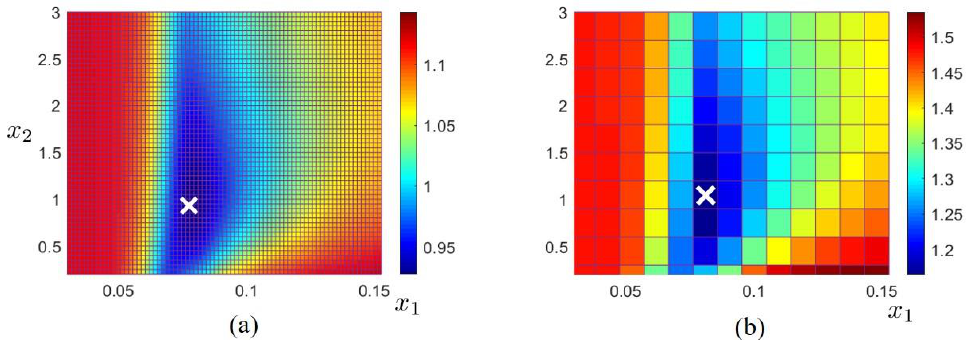
Figure 7. Cost function values for x 3 = 60 m. ( a ) Function values for a 1000 s simulation time and fine grid. ( b ) Function values for a 125 s simulation time and coarse grid. The white crosses represent the minimum point acquired from each calculation.